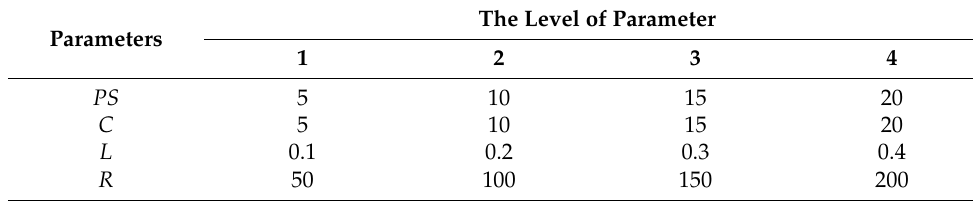
Table 2. Parameter level factor.